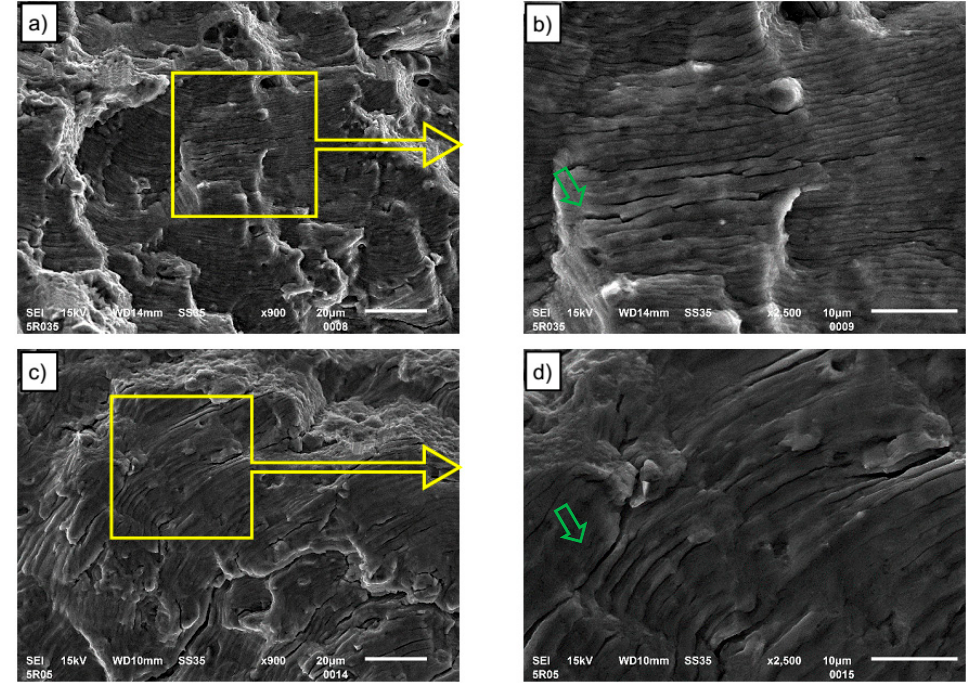
Figure 12. Fatigue crack propagation regions for base material at different strain amplitudes: ( a ) and ( b )— ε ac = 0.35% and ( c ) and ( d )— ε ac = 0.5%.